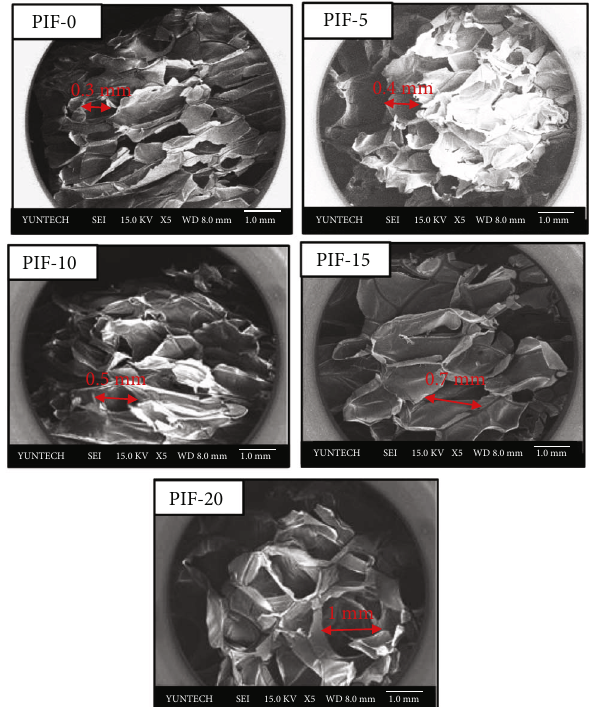
Figure 10: SEM images of cellular structure of PIFs with various HMDA